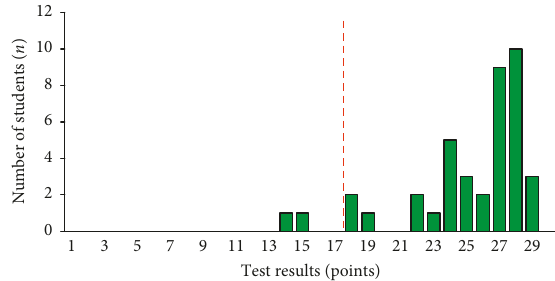
Figure 6: Distribution of points in the obligatory test of a subset of the test group shown above (cohort 3). These are students which did not attend the voluntary but the obligatory test ( n � 37). The dotted line marks the passing grade of 60%.